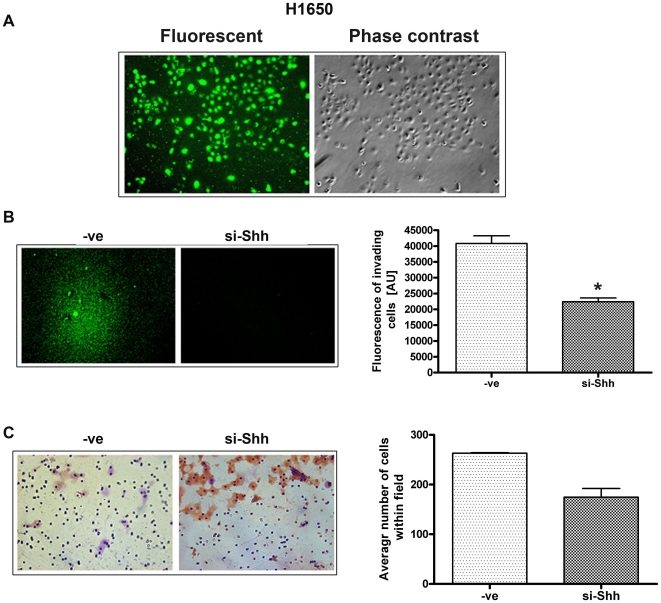
Down-regulation of Shh signaling in NSCLC cells lines (H1650 cells) leads to reduced cell motility and invasion.(A): Transfection efficiency was assessed by GFP. (B) Matrigel-Coated membrane assay where cells were labeled with DiIC12 fluorescent dye. (C) Matrigel-Coated membrane assay where cells were labeled with immune-staining kit (Quik staining kit). (B and C right panel) also show quantitative data analysis. (*  =  p<0.05).